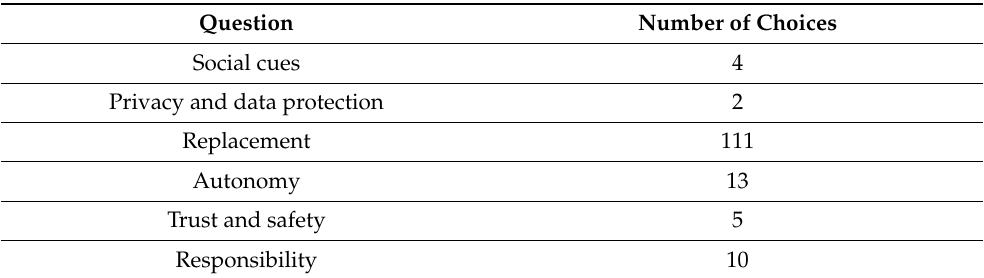
Table 6. Output from the choice question “Which aspect related to ethics in Robotics worries you the most?”.